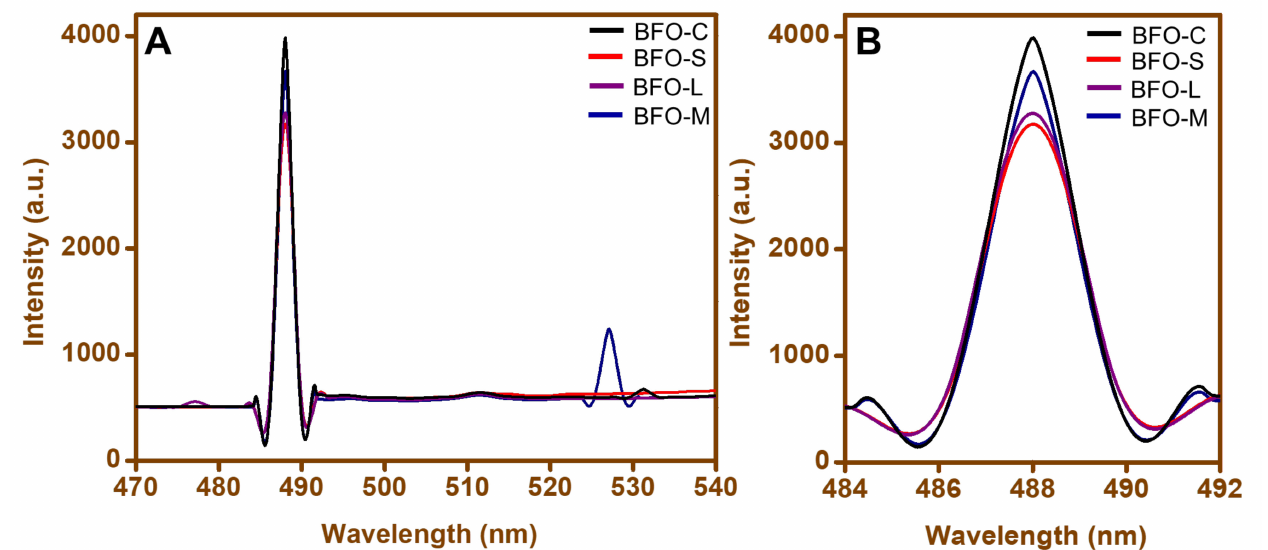
Figure 4. ( A ) PL spectra for (a) BFO-C, (b) BFO-S, (c) BFO-L, and (d) BFO-M nanoparticles and ( B ) an enlarged PL intensity around the 487 nm